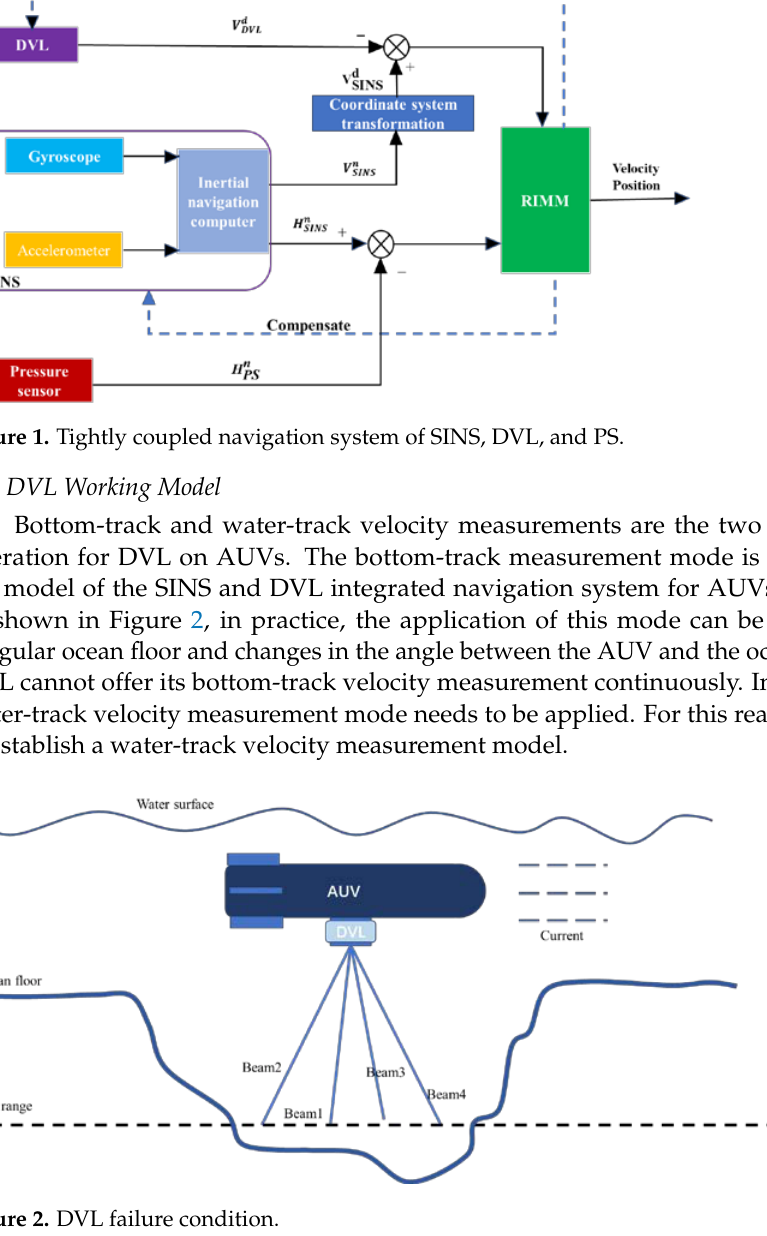
Figure 2. DVL failure condition.